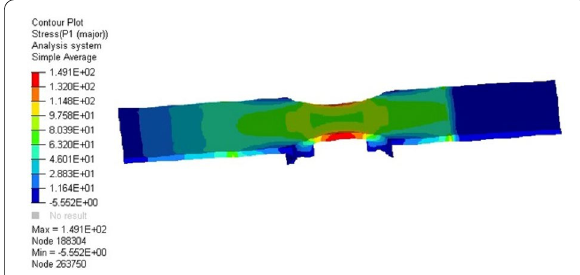
Figure 22 FEA calculation of 6005 aluminum alloy butt weld test sample